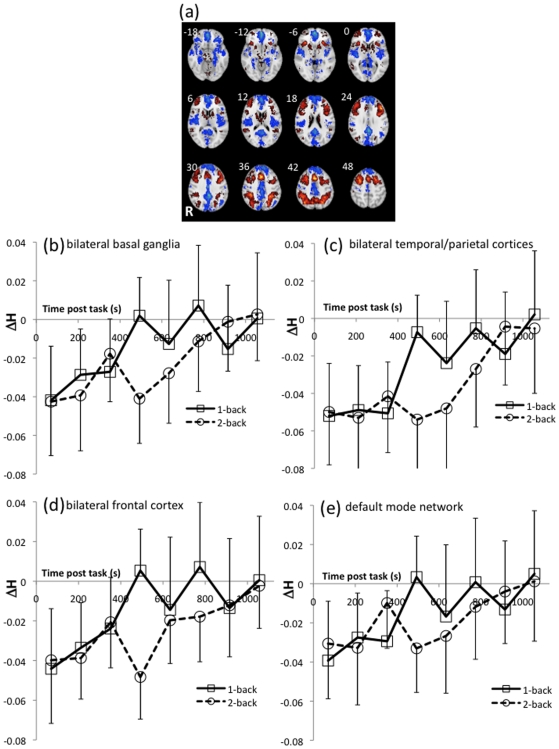
Task-activated brain regions and the recovery of fractal scaling of endogenous oscillations after task performance.(a) Within-group map of activated (red) and deactivated (blue) regions from a contrast of n-back versus zero-back (control) trials of the working memory task. Axial slice locations are in mm coordinates of the MNI stereotaxic template. The left of the image is the right of the brain. Threshold for significance was at the cluster level and set such that one false-positive cluster was expected under the null hypothesis (equivalent p = 3.6×10−3). (b–e) Post-task recovery of fractal scaling (ΔH) for low and high working memory loads, extracted from activated regions clusters 1–3 and deactivated regions cluster 1 (see table 1 for anatomical description). Error bars are between-subject standard deviations. Note that in the immediate post-task period, values of H were lower than before task performance, indicating a relative loss of long-range autocorrelations or long memory properties in the endogenous dynamics. Endogenous dynamics tended to recover their pre-task parameter values quite slowly over the course of several minutes following completion of the task and the rate of recovery was faster following completion of the less demanding version of the working memory task.